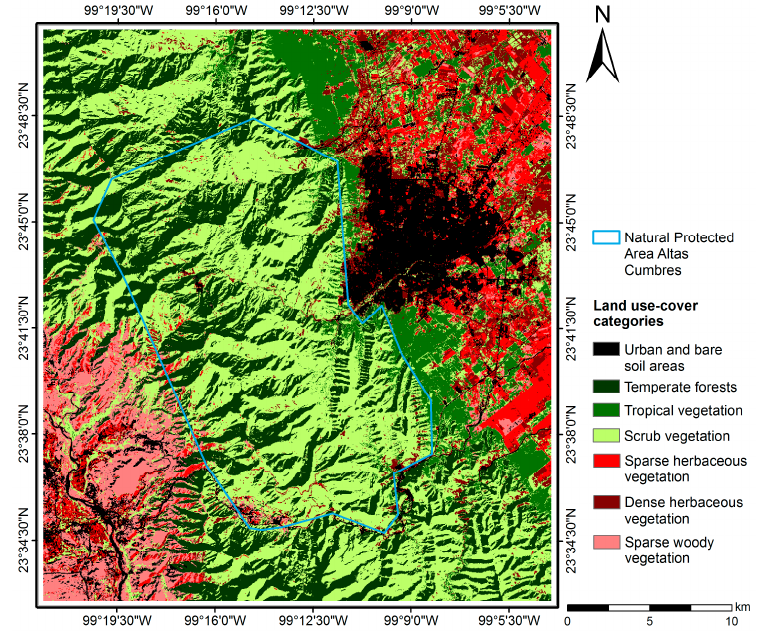
Figure A5. Land use-cover in 2015, Natural Protected Area Altas Cumbres and adjacent area. Victoria, Tamaulipas, Mexico.